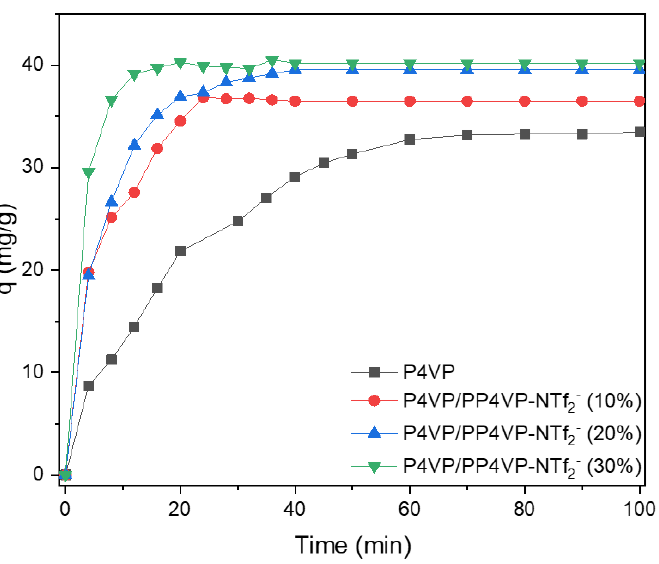
Figure 5. Effect of contact time on the adsorption capacity of P4VPy and P4VPy/PP4VPyNTf 2 − nanofibers.